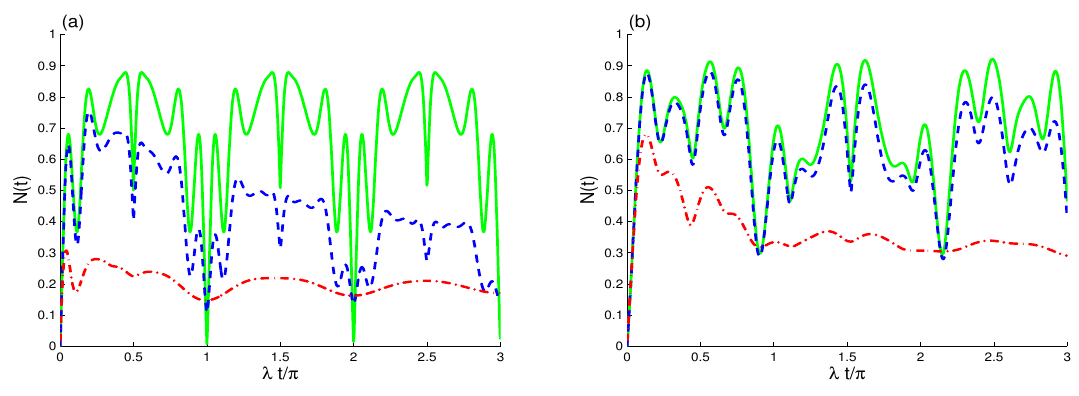
Figure 7. As Figure 6 ( a ) but for different cases: ( k , α ) = ( 1,5 ) in ( a ) and ( k , α ) = ( 1 different decoherence values of γ : γ / λ = 0 (green solid curves), γ / λ = 0.001 (blue dashed curves), and γ / λ = 0.03 (red dashed dot